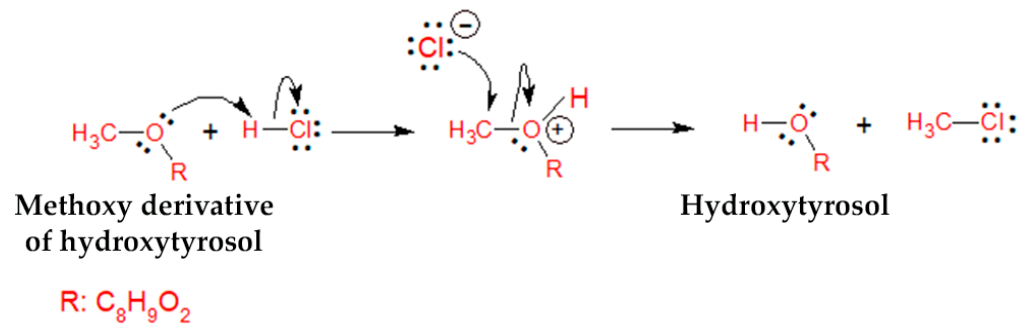
Figure 4. Proposed S N 2 reaction mechanism between the methoxy derivative of hydroxytyrosol and hydrochloric acid for the formation of hydroxytyrosol.